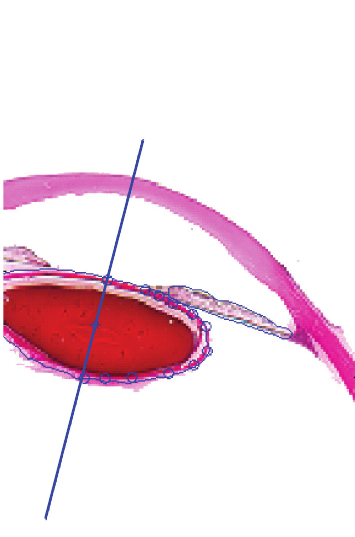
Figure 6: Identifying the symmetry axis of the human eye slice image.